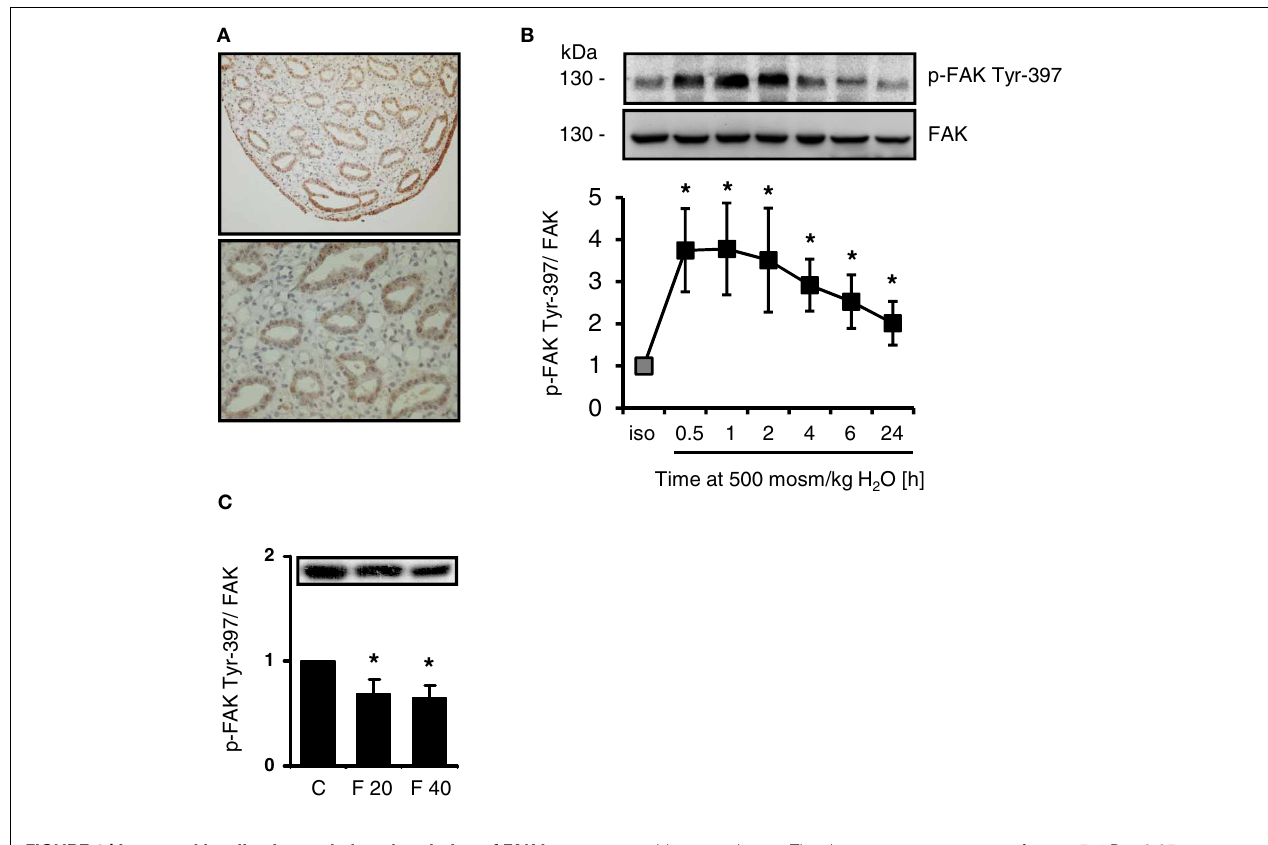
blots are shown. The data are means ± s.e.m. for n = 5; ∗ P < 0 . 05 vs. isotonic control. (C) Rats received furosemide (20mg kg/bw) or PBS (control, C ) via intravenous injection. After 20 ( F 20) and 40 ( F 40) min, FAK Tyr-397 phosphorylation was assessed by Western blot analysis in the renal papilla and normalized to total FAK abundance. Means ± s.e.m. for n = 3; ∗ P < 0 . 05 vs.